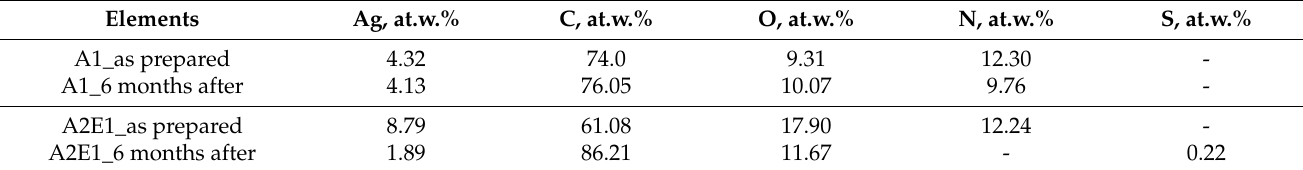
Table 1. The chemical elemental analysis data in accordance with as-prepared and oxidized A1 and A2E1